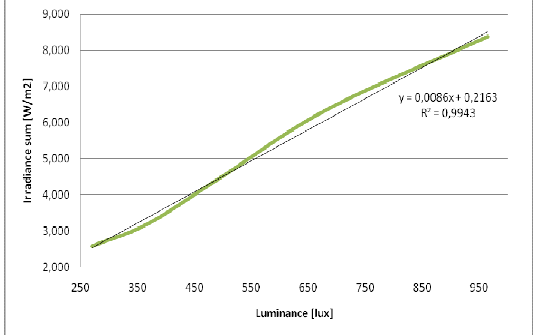
Figure 4. Relationship between the scene luminance and sum of irradiance within the 900-1700nm